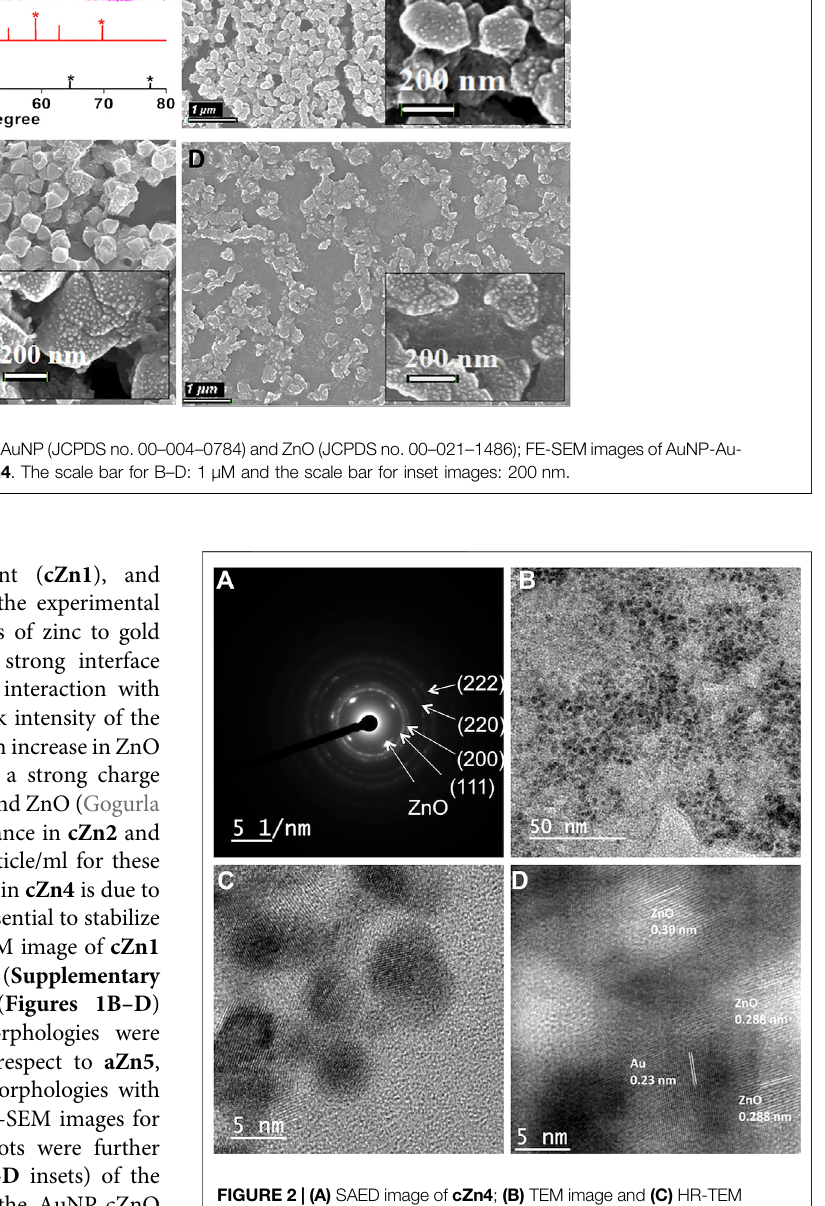
cZn1 , cZn2 , cZn3 , and cZn4 , respectively. This change in the